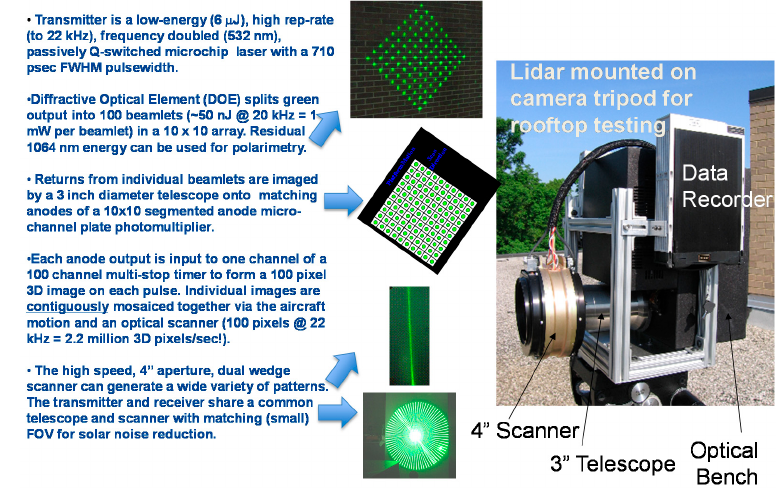
Figure 2. Leafcutter was the first Sigma Single Photon Lidar (SPL) to split the laser beam into 100 beamlets. In early mapping missions, the dual wedge scanner was used to generate either linear raster scans at 45° to the flight line or a conical scan with cone half angles up to 13.5 degrees. At the design AGL of 1 km, pixels on the ground were separated by 15 cm. Contiguous alongtrack and crosstrack mapping on a single pass was achieved by ensuring: (1) that the distance traveled by the aircraft during one scan cycle did not exceed the 1.5 m dimension of the single pulse array; and (2) that ground array patterns from subsequent pulses overlapped along the full circumference of the conical scan and the length of the linear scans.